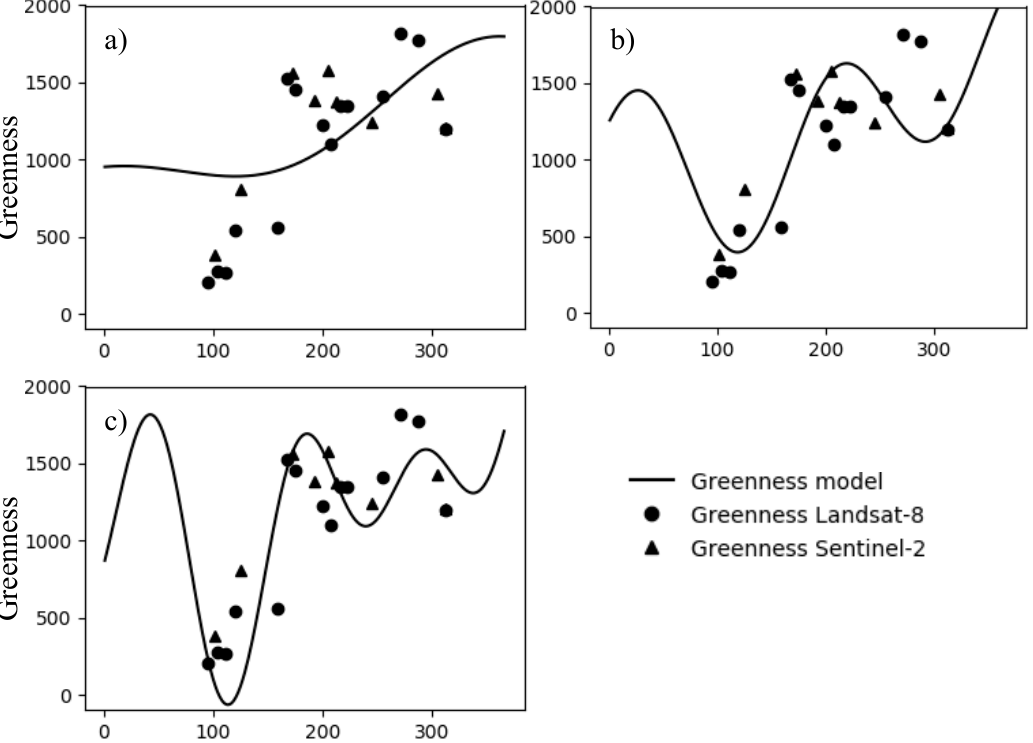
Figure A1. Illustration of ( a ) annual CCDC model, ( b ) annual + bi-annual CCDC model, and ( c ) annual + bi-annual + tri-annual CCDC model given the same number of observations.